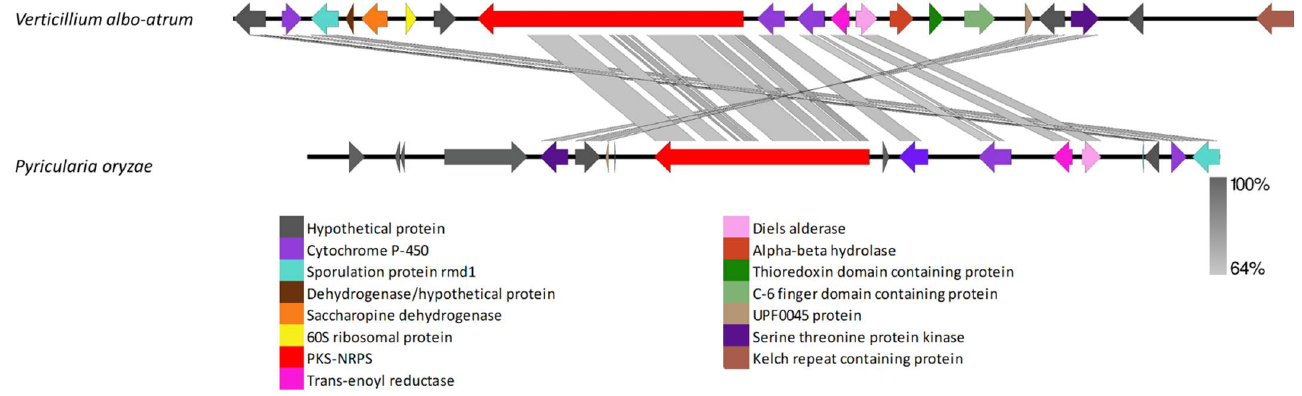
Figure 10. Comparison of putative cluster genes for Verticillium albo-atrum VRPKS-I-3 and P. oryzae cytochalasan clusters. The arrowheads indicate the direction of transcription and the types of genes common to the two clusters being compared are displayed in the same color. Shaded lines represent similarities between nucleotide sequences.